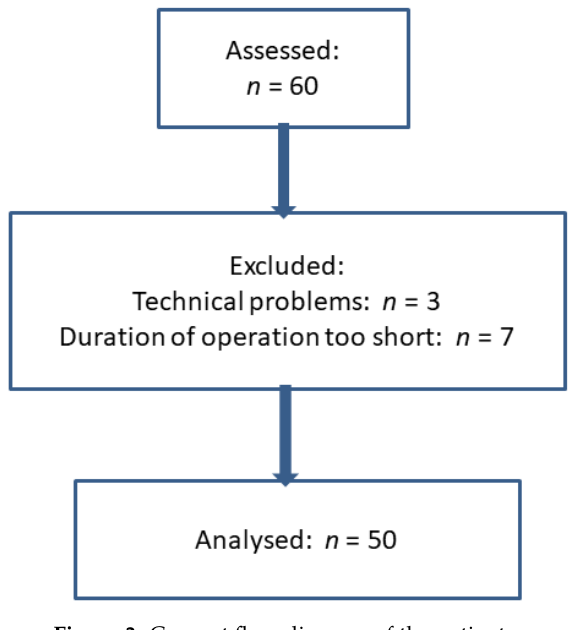
Figure 3. Consort flow diagram of the patients. Table 1. Patient characteristics ( n = 50) and initial rocuronium